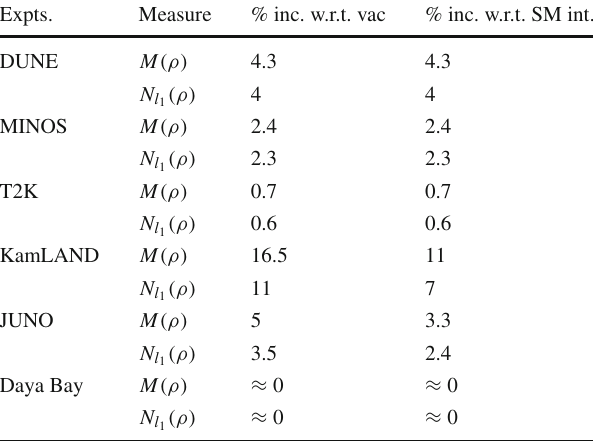
Table 3 Percentage (%) increase in Bell’s inequality parameter M (ρ) and NAQC in presence of NSI in comparison to vacuum and SM inter- action for six different experimental set-ups.